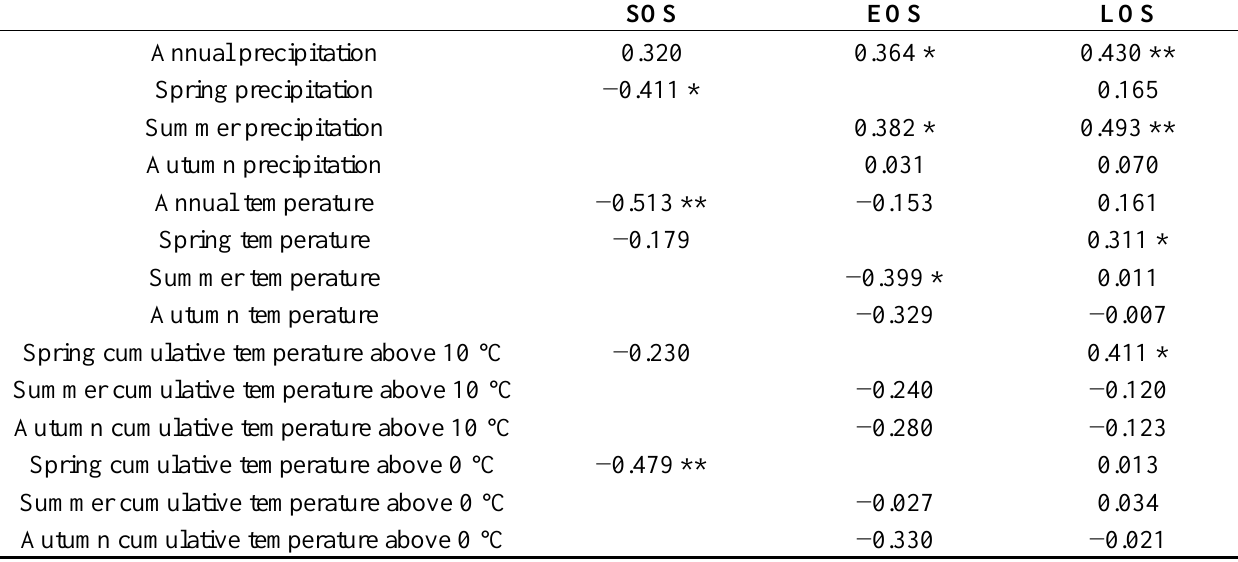
Table 2. Correlation coefficients between phenological parameters and climatic factors in the steppe